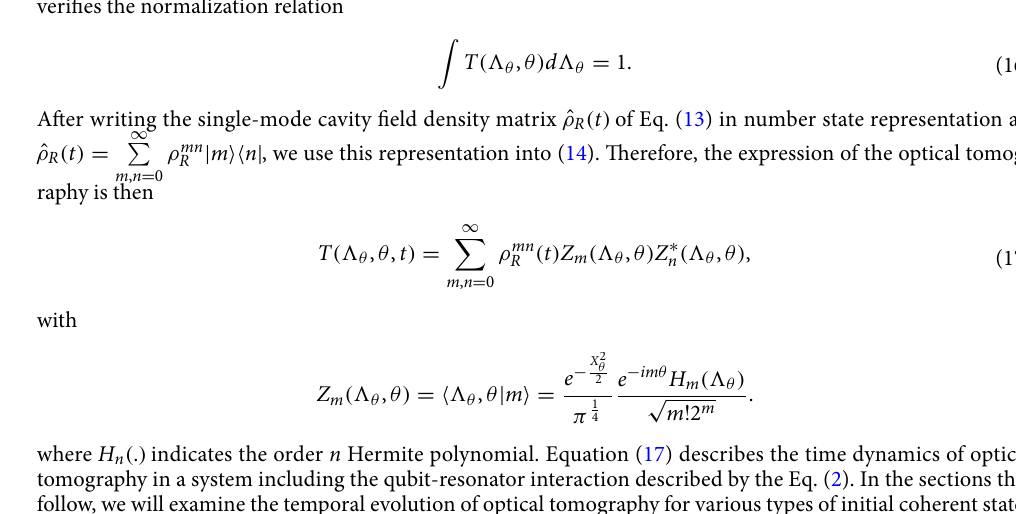
α . | ± � θ -plane except − ( 2 n ( 1 1 ) , 0 )( n 0, 1 ) . The results of the Fig. 1b,c show that 2 + = =